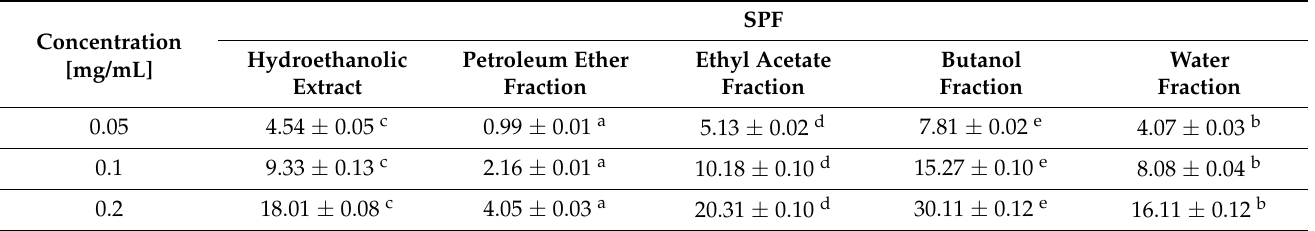
Table 6. Sun protection factor (SPF) of the hydroethanolic extract of the aerial parts of Sideritis raeseri subsp. raeseri and its